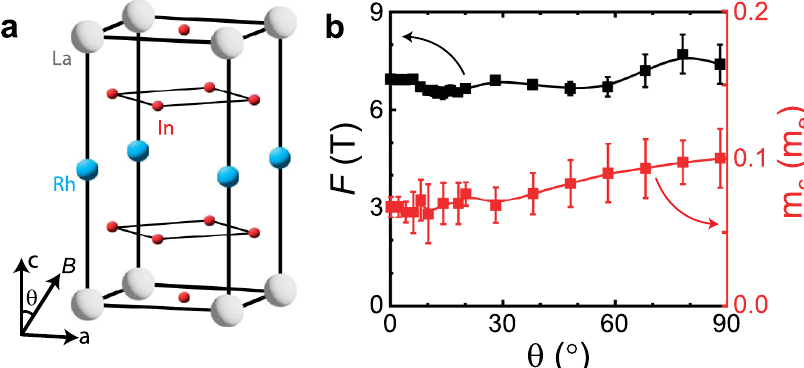
Fig. 1 | Angular dependence of quantum oscillation frequency and cyclotron mass in LaRhIn 5 . a Illustration of crystal structure and fi eld orientation. Here B representsthemagnetic fi eld,andthe fi eldangleisde fi nedastheanglebetweenthe crystallinec-directionandmagnetic fi eld. b Shubnikov-deHaasoscillationfrequency